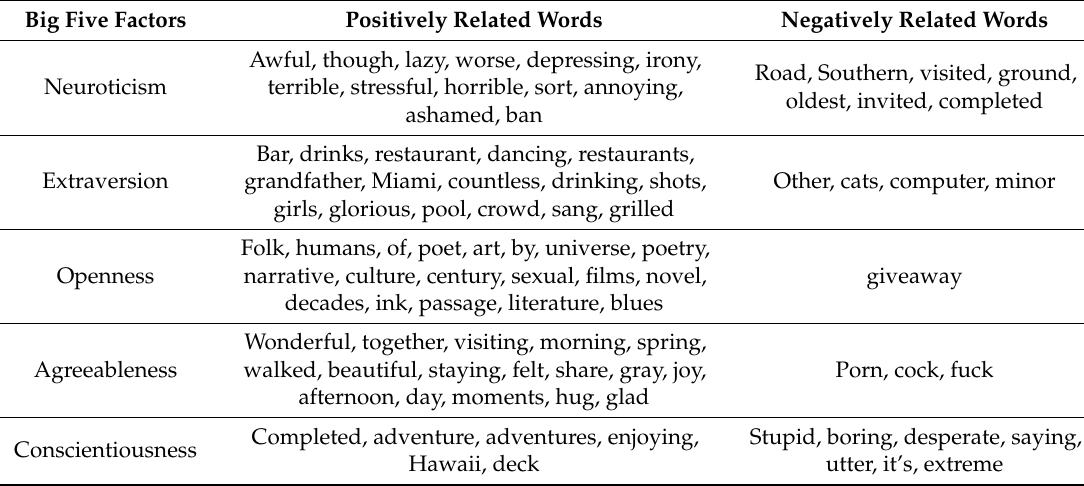
Table 2. Big Five Factor (BFF)-related seed